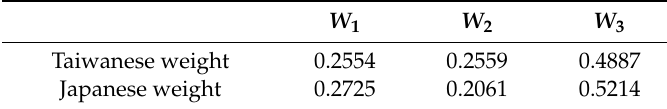
Table 8. Taiwanese and Japanese